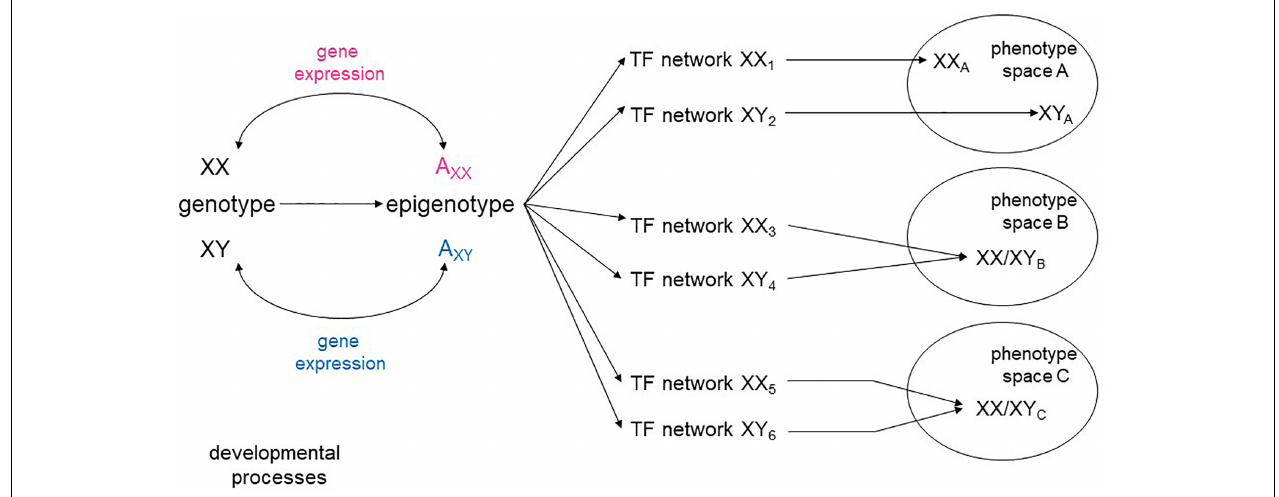
FIGURE 1 | Sex-specific transcriptional networks and phenotype maps. Schematic representation of the relationships between genotype, transcriptional networks, and final phenotype during development. Male and female genotypes, represented as XY and XX produce distinct epigenotypes, with effects on and counter-effects from the autosomes (A). Modifications of the epigenotype on the autosomes lead to transcriptional changes that in turn influence expression from the sex chromosomes. Different transcription factor (TF) networks can either determine distinct phenotypes (space A) or converge to an equivalent phenotype (spaces B, C).